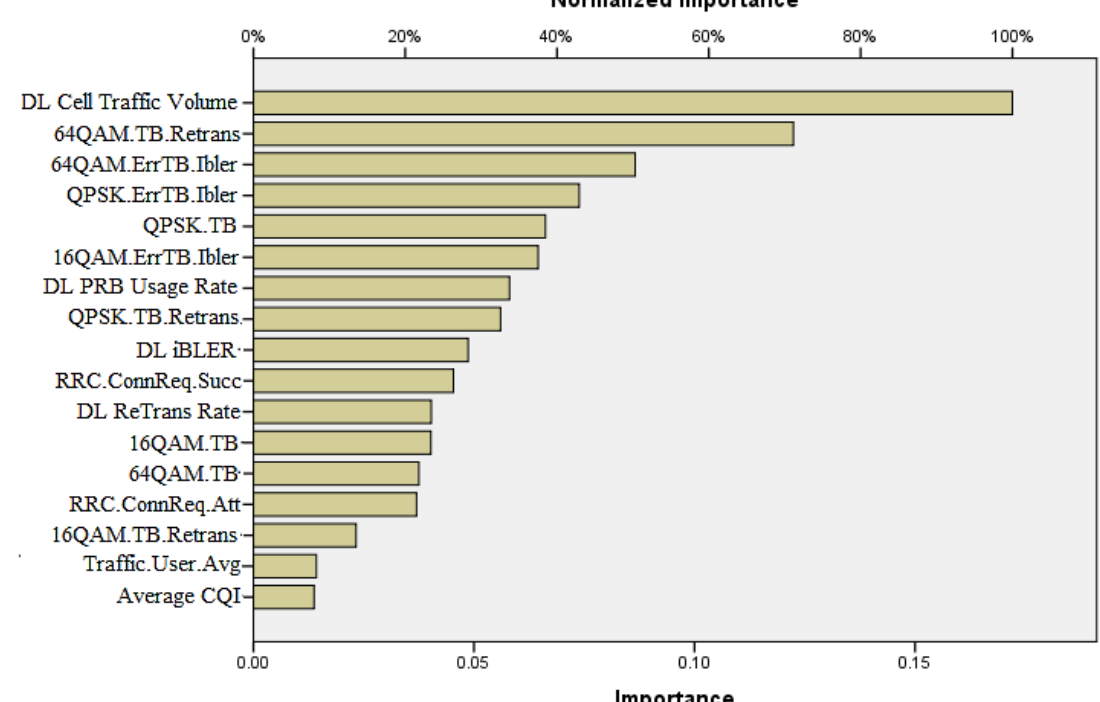
Figure 9. Graphical overview of the results of the influence of the importance of individual independent variables in the MLP prediction model.